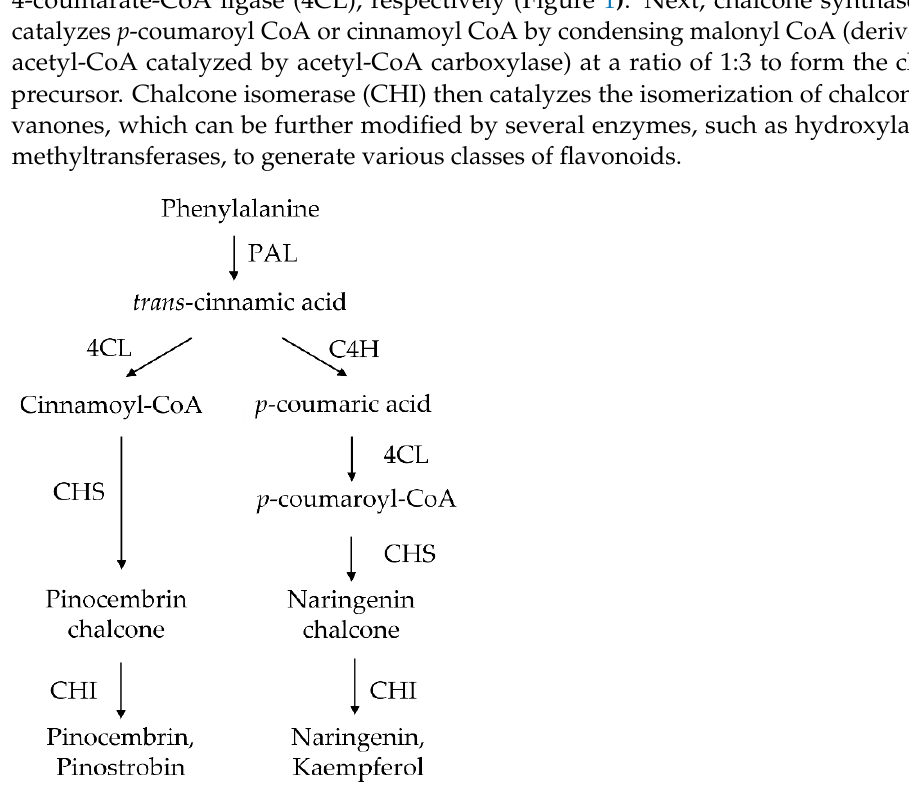
Figure 1. Phenylpropanoid biosynthetic pathway in plants.